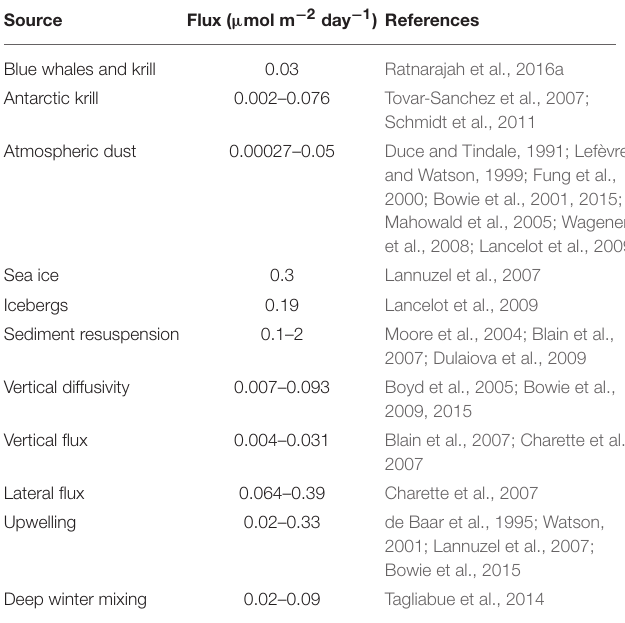
TABLE 1 | Flux of dissolved iron ( µ mol m − 2 day − 1 ) from various sources in the Southern